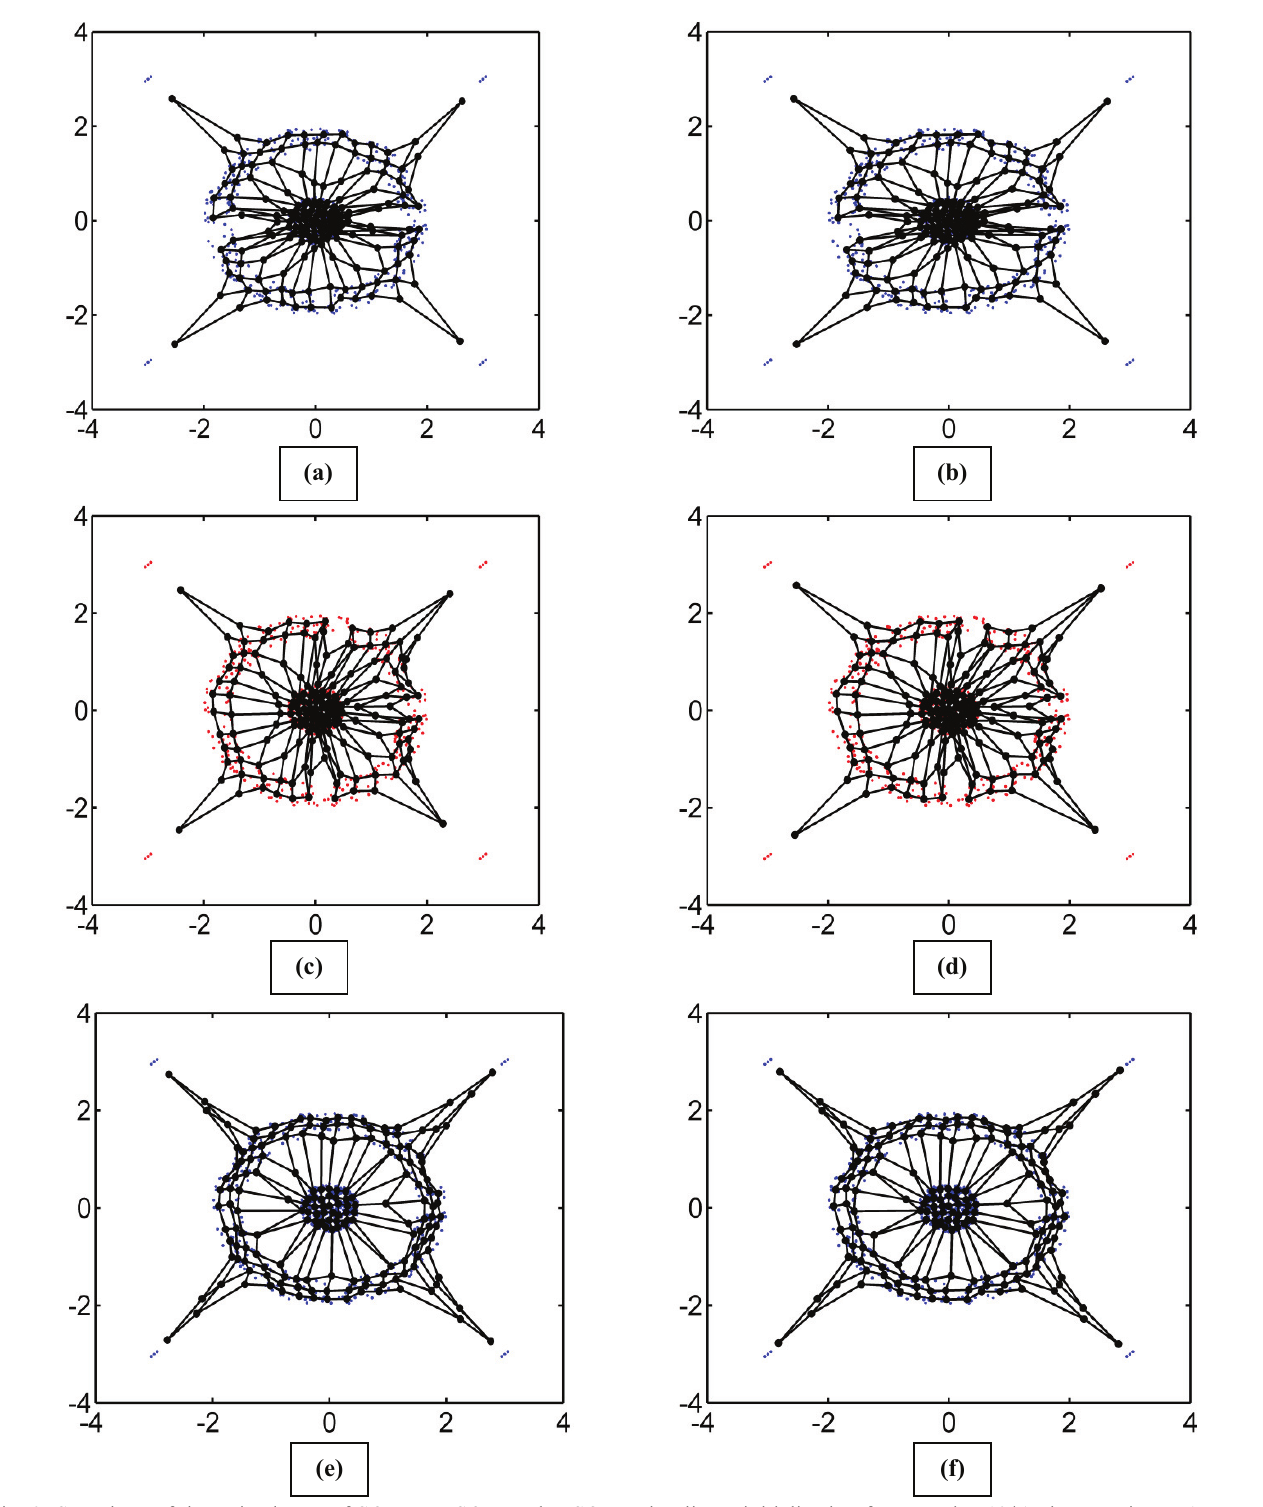
Fig. 3. Snapshots of the trained map of SOM, FN-SOM and E-SOM using linear initialization for map size 12*15 in Experiment 1. (a) Conventional SOM (ten epochs) (b) Conventional SOM (twenty epochs) (c) FN-SOM (ten epochs) (d) FN-SOM (twenty epochs) (e) E-SOM (ten epochs) (f) E-SOM (twenty